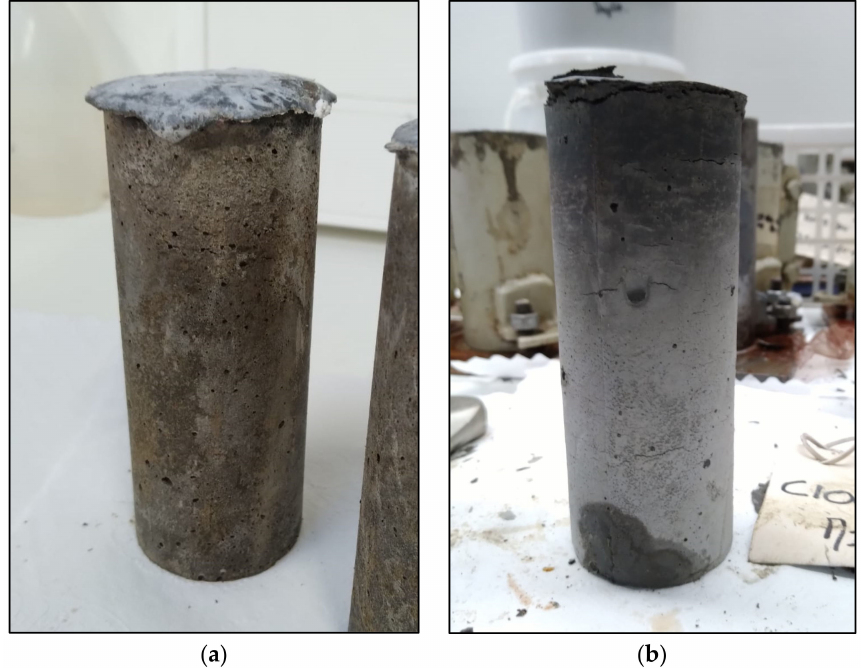
Figure 7. Appearance of geopolymers after curing: activated with ( a ) sodium hydroxide and ( b ) sodium